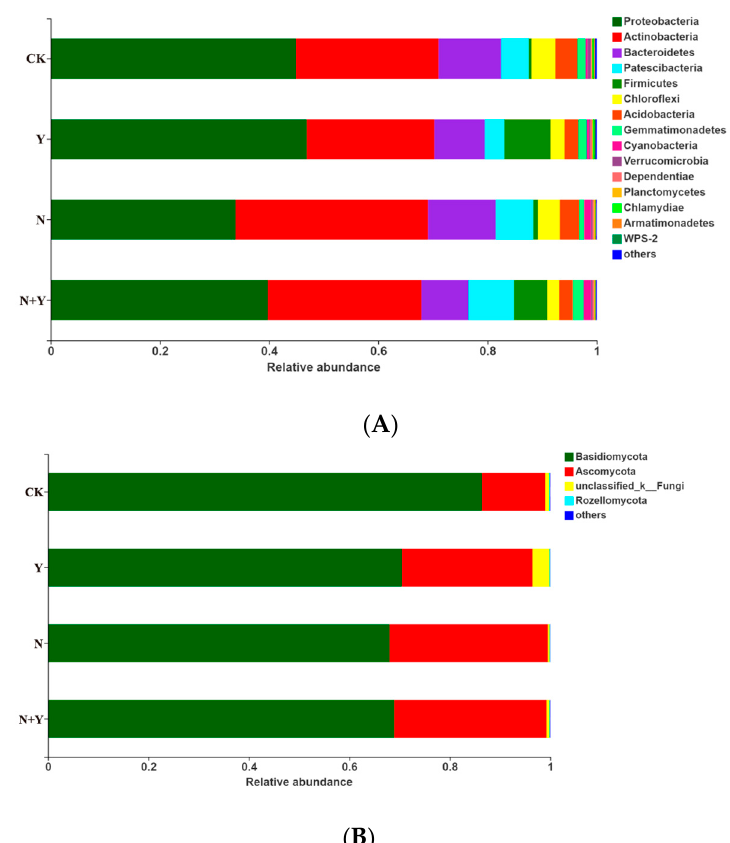
Figure 5. The relative abundance of bacterial ( A ) and fungal phyla ( B ) in samples collected from different treatments. Different treatments: CK (control), seedlings were irrigated with normal nutrient solution; Y, control + B. subtilis K424; N, four-strength control; N + Y, four-strength control + B. subtilis K424. “Others” indicates phyla with an extremely low abundance (<0.1%).